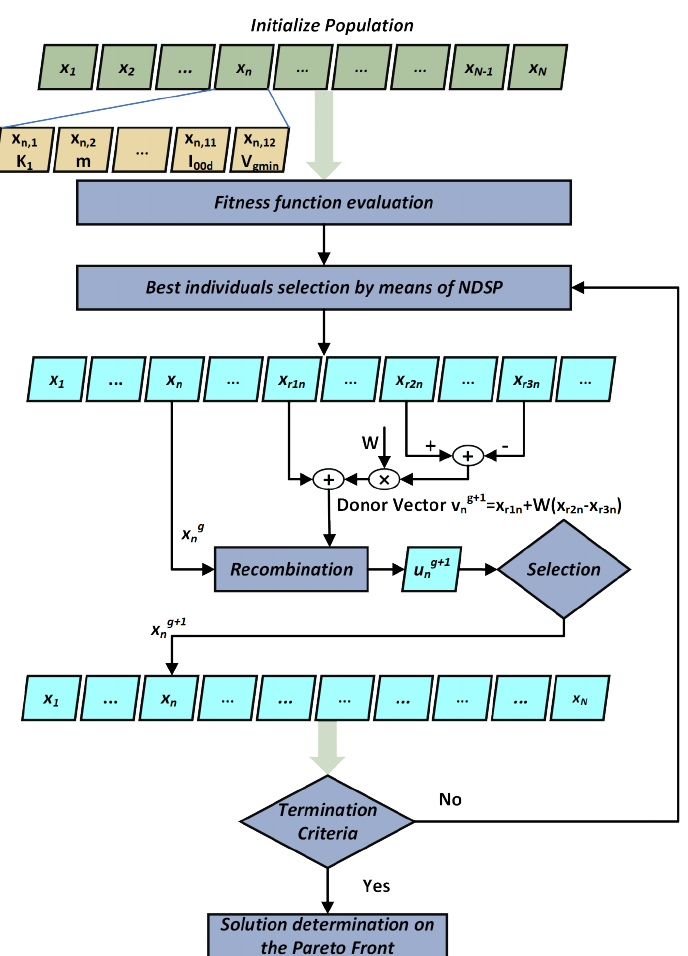
Figure 7. Block diagram of MODE algorithm with DE approach; selection phase is carried out by considering both fitness